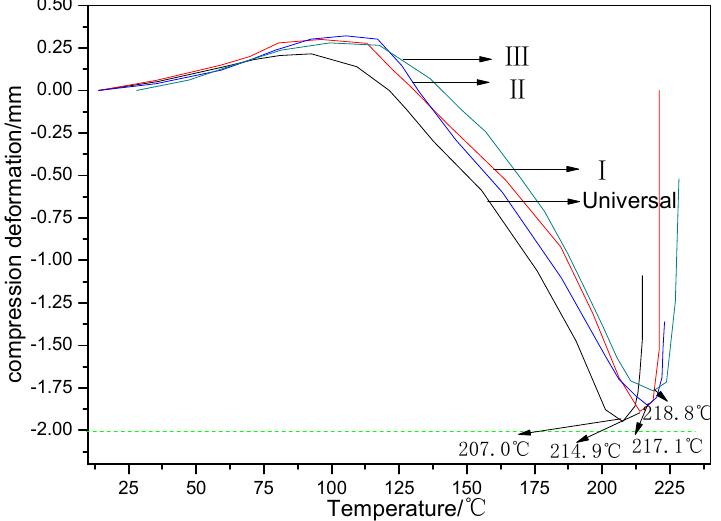
Figure 4. Heat distortion temperature curves of foam